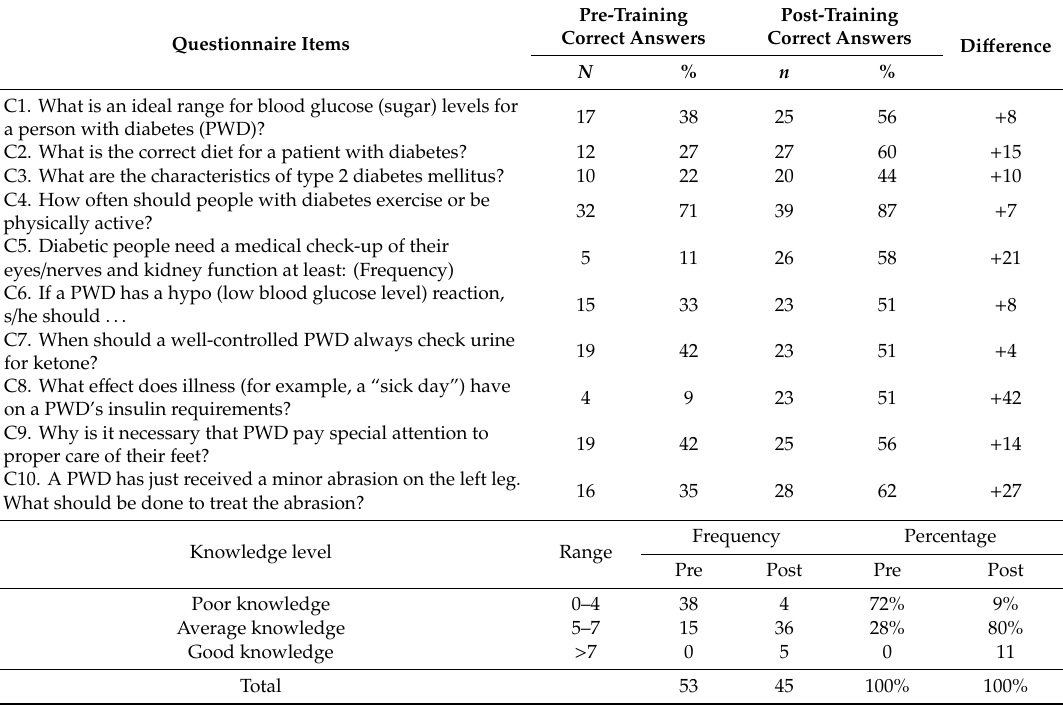
Table 3. Pre- and post-training knowledge scores.